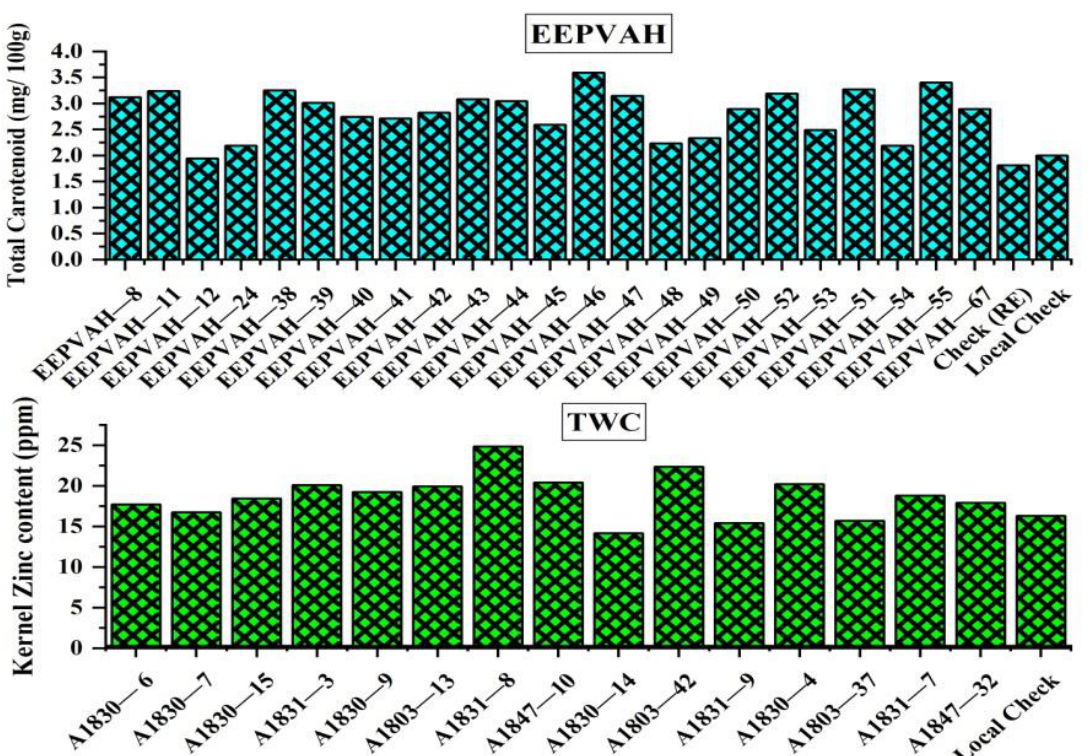
Figure 4. Total carotenoid and kernel zinc content of biofortified maize hybrids from the EEPVAH and TWC trials conducted in season-2. Composite samples were taken from each genotype in both the trials and submitted to the laboratory within 30 days of harvesting of the crop.